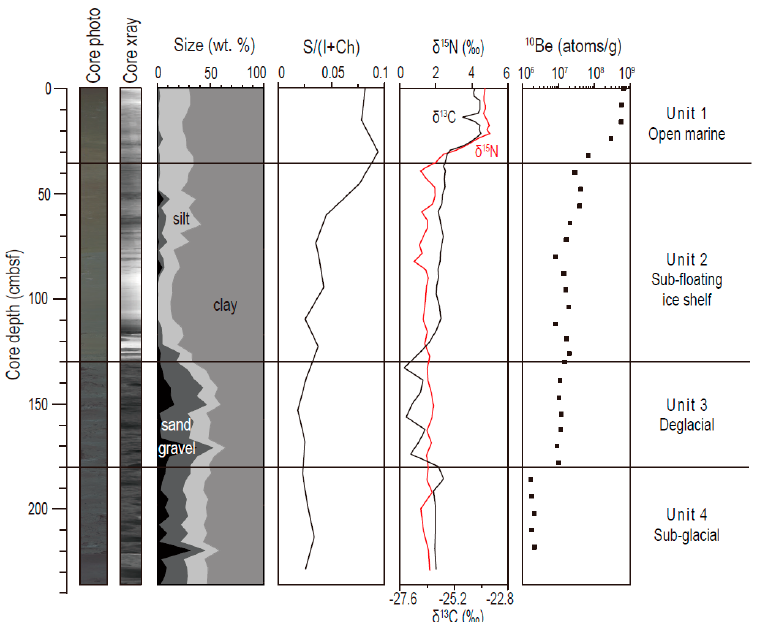
Figure 2. Down-core variations in sedimentary facies in four distinct lithological units from top (U1) to bottom (U4): relative grain size, clay mineral ratio of smectite/(illite + chlorite), and isotopic composition ( δ 13 C and δ 15 N), with 10 Be concentration (Jeong et al., 2018) [20].